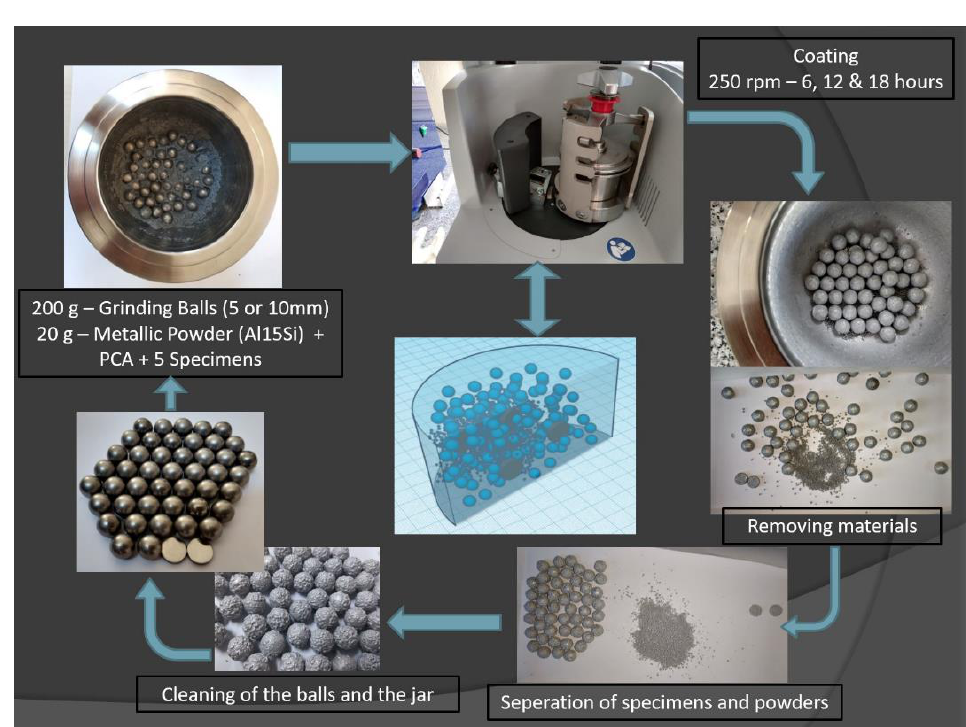
Figure 1. Schematic representation of the coating process cycle.